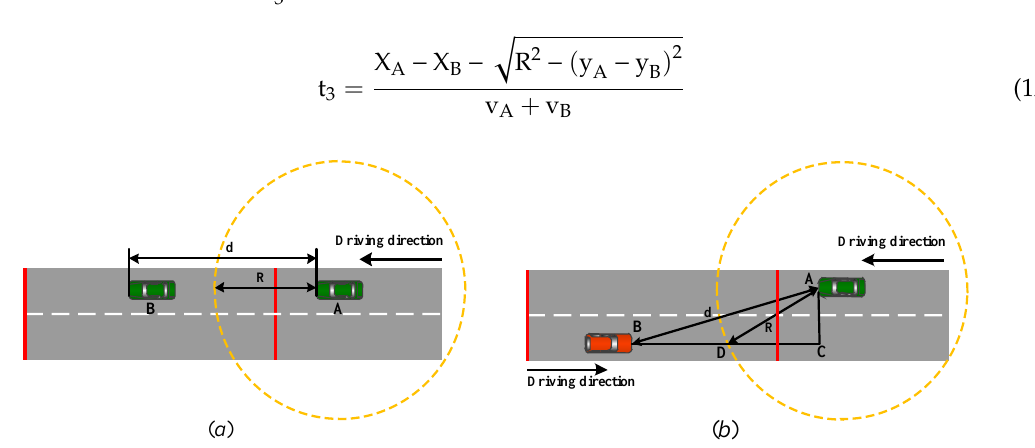
1 Figure 5. Car B is running in C 1 : ( a ) Car B is running in the same direction as car A; ( b ) Car B is running C : ( a ) Car B is running in the same direction as car A; ( b ) Car B is Figure 5. Car B is running in 1 1 in the opposite direction to running in the opposite direction to A.